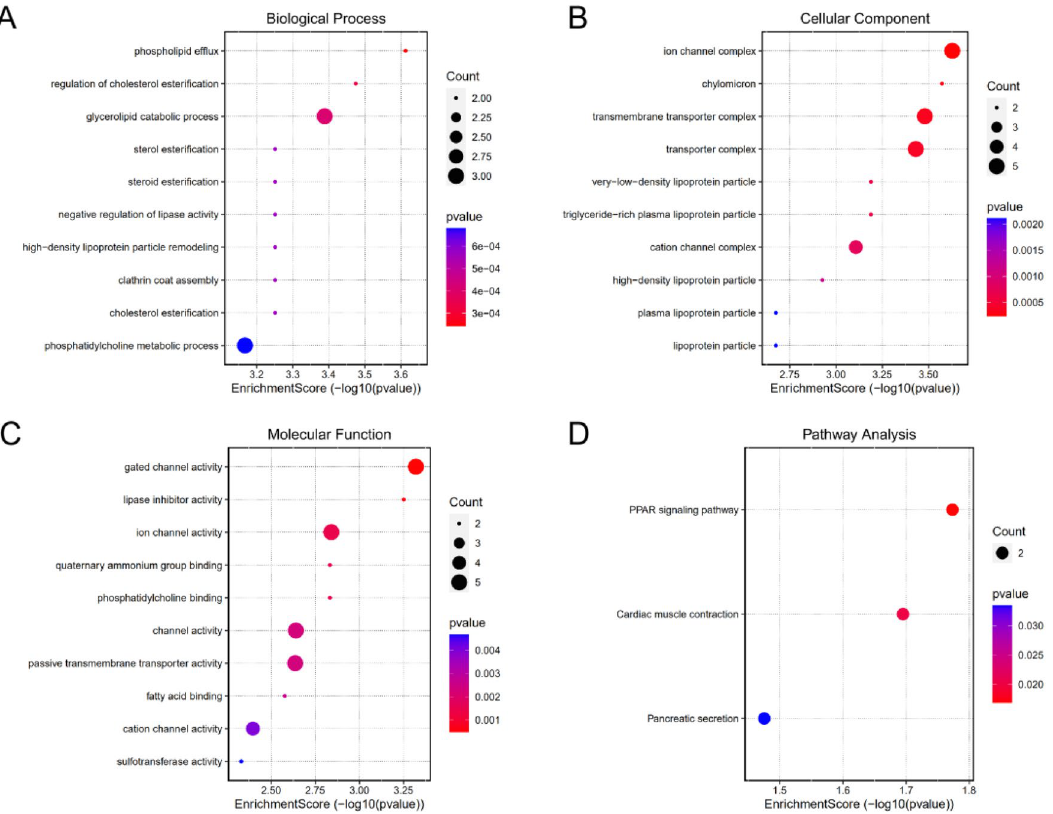
Figure 3. GO and KEGG enrichment analysis of 41 DEGs related to prognosis in EC. ( A ) Biological Process (BP). ( B ) Cellular Component(CC). ( C ) Molecular Function (MF). ( D ) Kyoto Encyclopedia of Genes and Genomes (KEGG). (According to the p value from small to large, the color of the circle increases from red to blue. The size of the circle indicates the count, that is, the number of